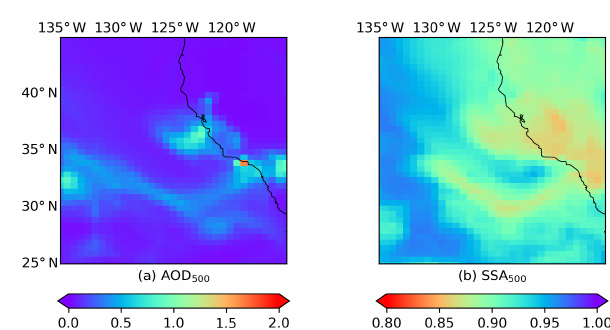
Figure C4. MERRA-2 M2T1NXAER averaged between 12:00 and 15:00LT for the Californian fire event on 11 November 2018: